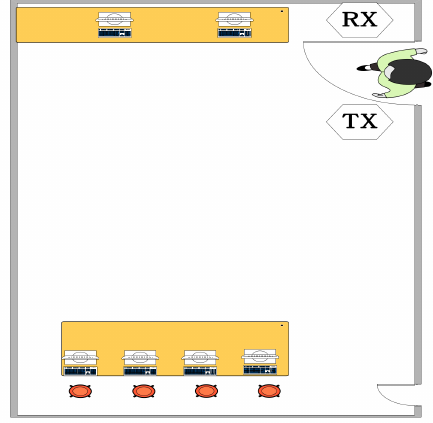
Figure 8. Experiment with a large empty laboratory.